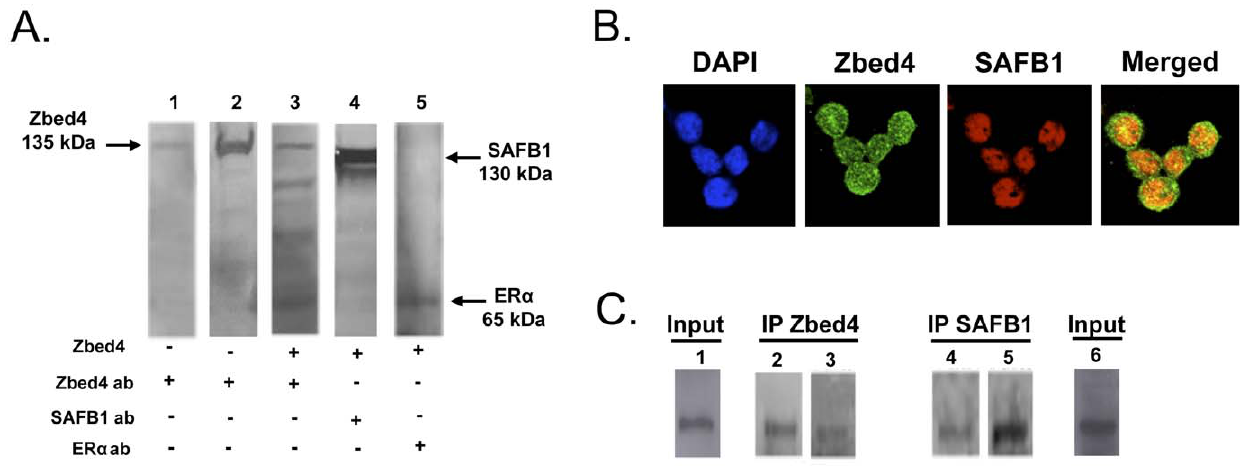
Figure 7. Zbed4 interacts with SAFB1 invitro and invivo . A. Membrane overlay assay: Proteins were resolved on SDS-PAGE and transferred to a PVDF membrane. Lane 1: cell lysate; lane 2: purified Zbed4 protein; lanes 3, 4 and 5: cell lysate incubated with Zbed4 protein (overlay). Lanes 1, 2 and 3 were probed with the Zbed4 antibody and lanes 4 and 5 with the SAFB1 and ER a antibodies, respectively. B. Subcellular co-localization of Zbed4 with SAFB1 , carried out as described in Materials and Methods. The merged image clearly shows that Zbed4 co-localizes with SAFB1 in the nucleus of Y79 retinoblastoma cells. DAPI was used to stain the nuclei. C. Co-immunoprecipitation experiments were performed using Y79 retinoblastoma cell extracts. Both Zbed4 and SAFB1 were detected in the immunoprecipitated proteins obtained with Zbed4 antibody (left panel) or SAFB1 antibody (right panelIn each case, each duplicate lane of the blots obtained after SDS-PAGE of the immunoprecipitated proteins was incubated with Zbed4 or SAFB1 antibodies. Immunoprecipitation experiments were performed using Y79 retinoblastoma cell extracts (Input) and antibodies against Zbed4 or SAFB1. Duplicate aliquots of the proteins immunoprecipitated by each antibody were immunoblotted after SDS-PAGE with antibodies against Zbed4 (lanes 2 and 4) or SAFB1 (lanes 3 and 5). Both Zbed4 and SAFB1 are detected in each immunoprecipitate. Aliquots of Input material also show on the Western blots the presence of Zbed4 (lane 1) and SAFB1 (lane 6).